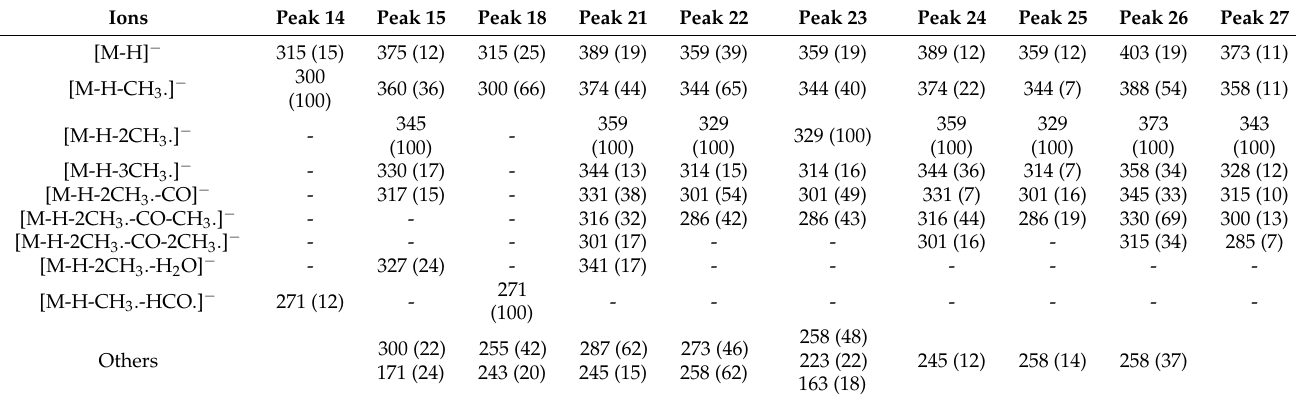
Table 4. MS/MS fragmentation patterns of methoxyflavonoids of the methanol 90% fraction of the total extract of C. cowellii . Ions Peak 14 Peak 15 Peak 18 Peak 21 Peak 22 Peak 23 Peak 24 Peak 25 Peak 26 Peak 27 [M-H] −